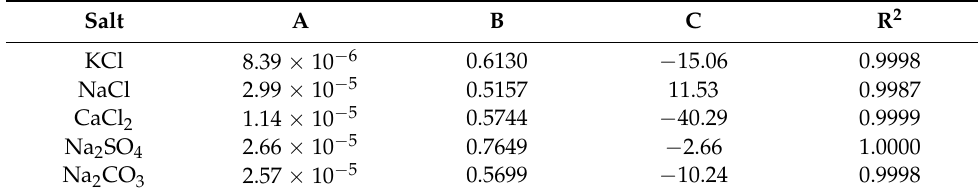
Table 1. Fitting parameters for Equation (1).